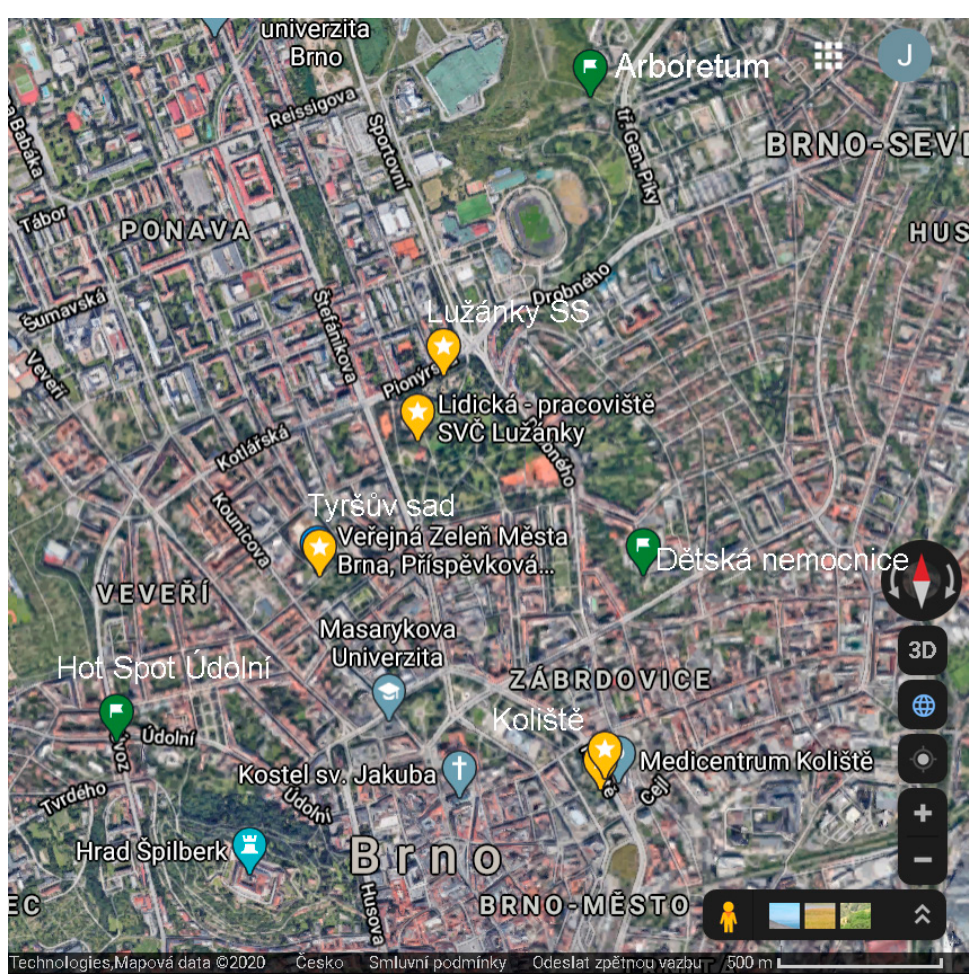
Figure 4. The sampling (yellow marks) and reference (green marks) localities.